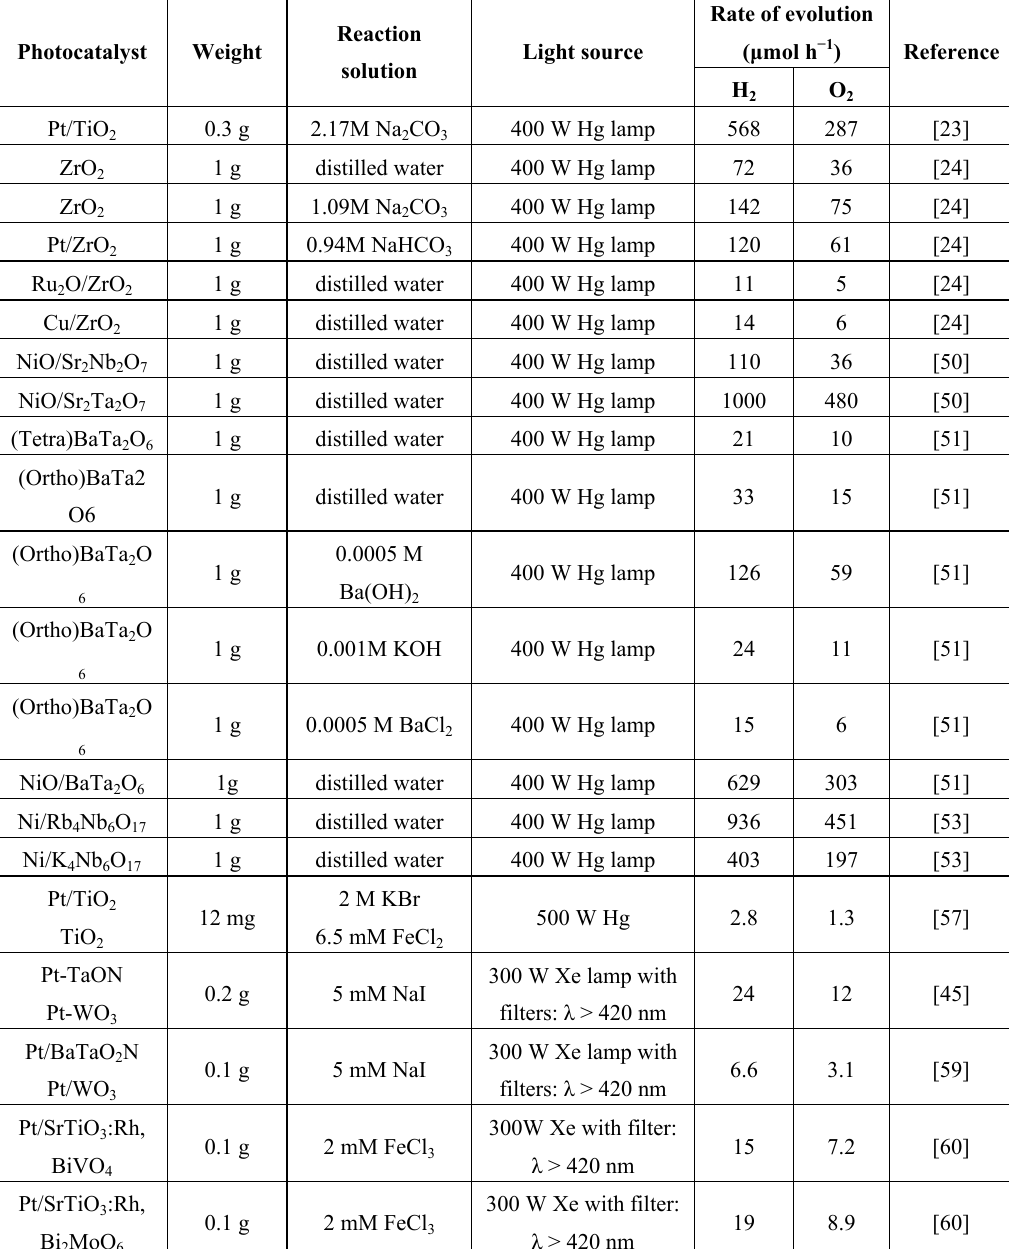
Table 1. Water splitting by photochemical-cell reaction over various photocatalysts.